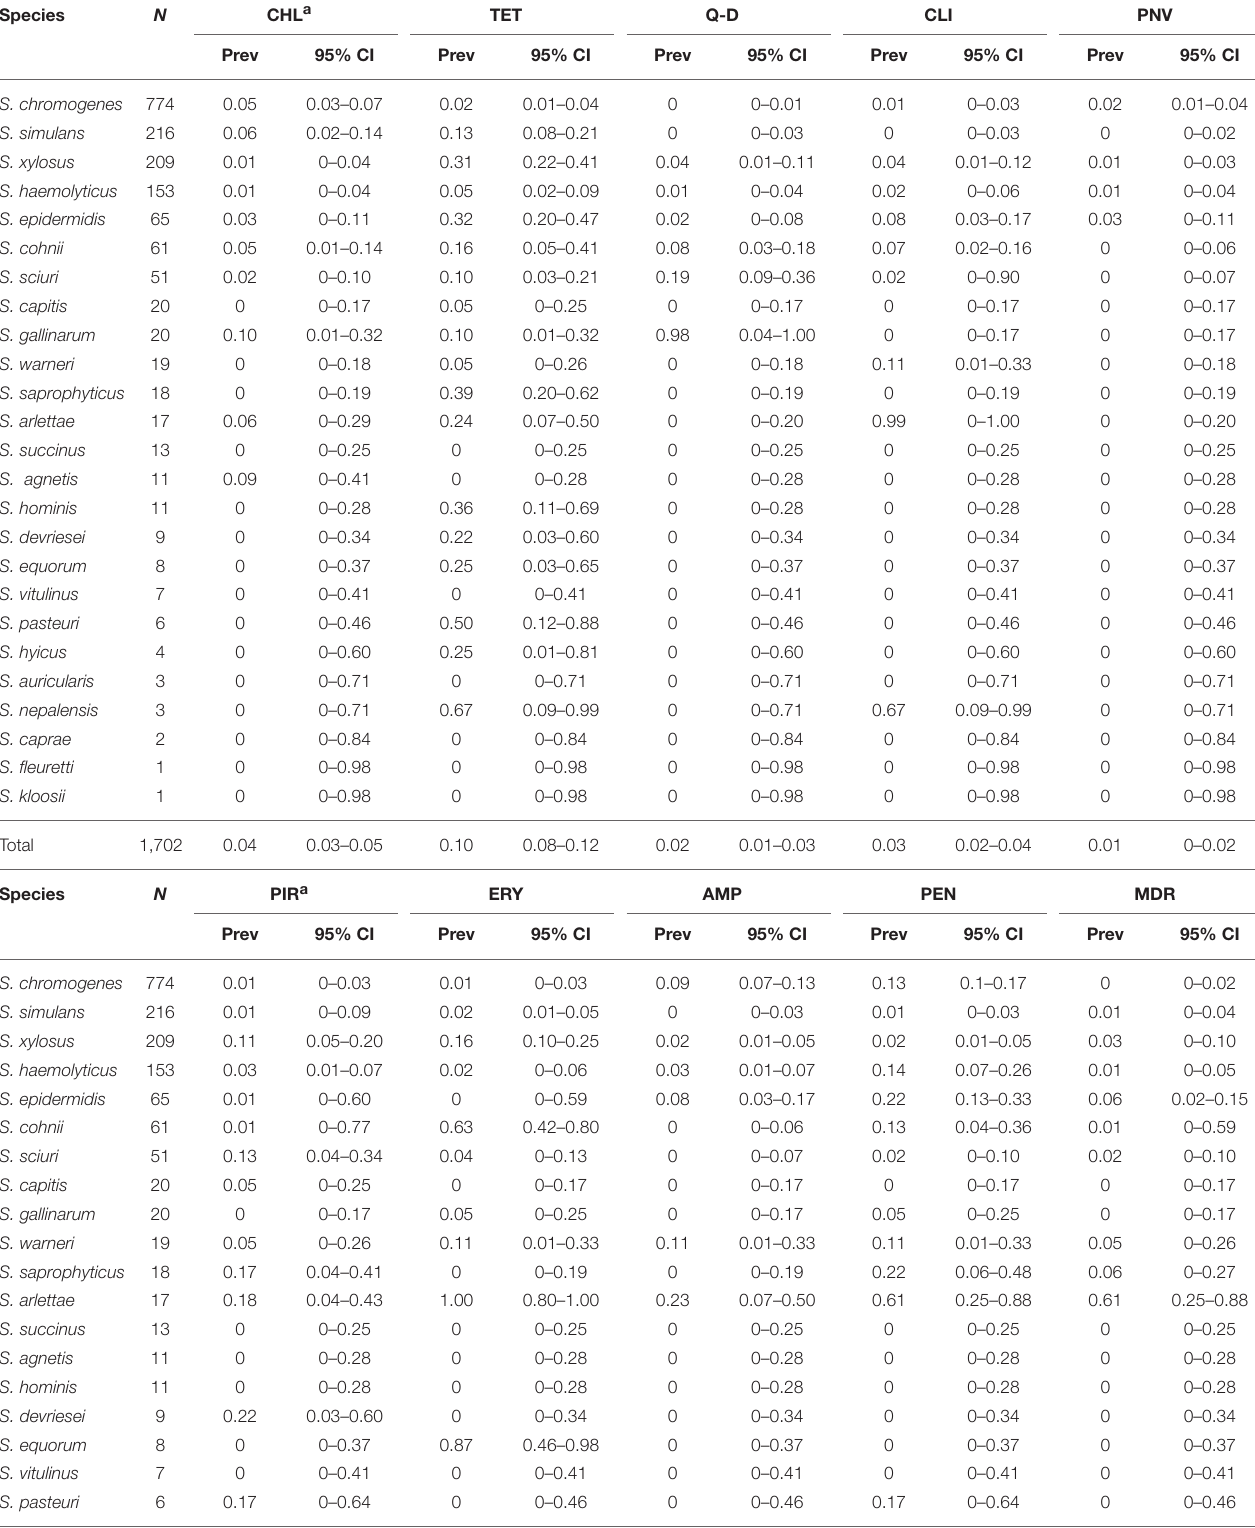
TABLE 1 | Prevalence (Prev) of the phenotypic antimicrobial resistance per isolate for 25 non- aureus staphylococci species isolated from bovine quarter milk samples collected in 89 Canadian dairy herds.